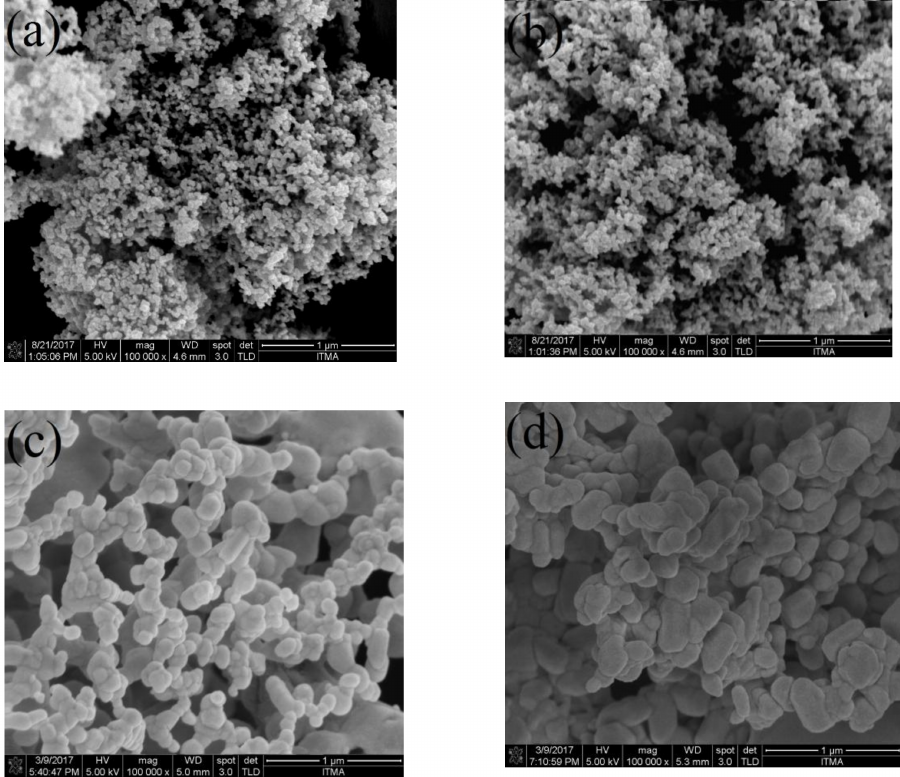
Figure 8. FESEM images for willemite NPs produced at 900 ◦ C with different calcination holding times: ( a ) 1 h, ( b ) 2 h, and ( c ) 3 h and ( d ) 4 h.